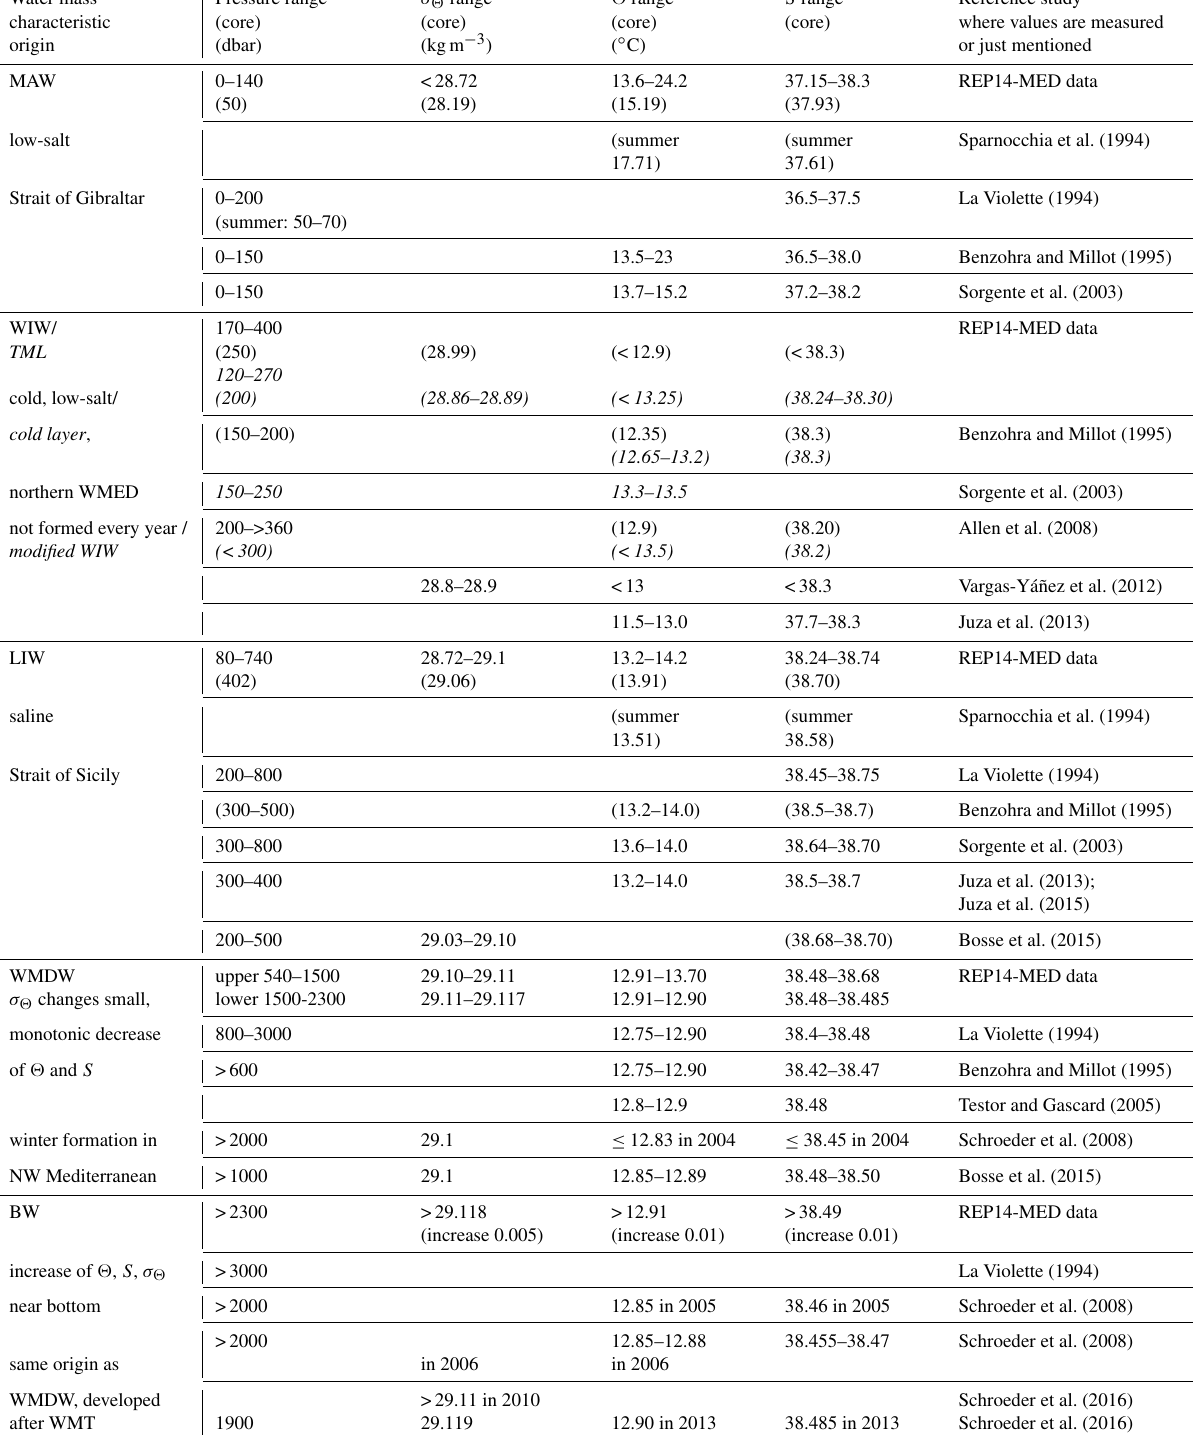
Table 2. Ranges and core characteristics of the parameters pressure, potential density anomaly ( σ (cid:50) ) , potential temperature ( (cid:50)) , and salinity ( S ) of water masses in the WMED obtained from literature and the REP14-MED data set. Specifications in brackets refer to core values. Italic indications correspond to TML